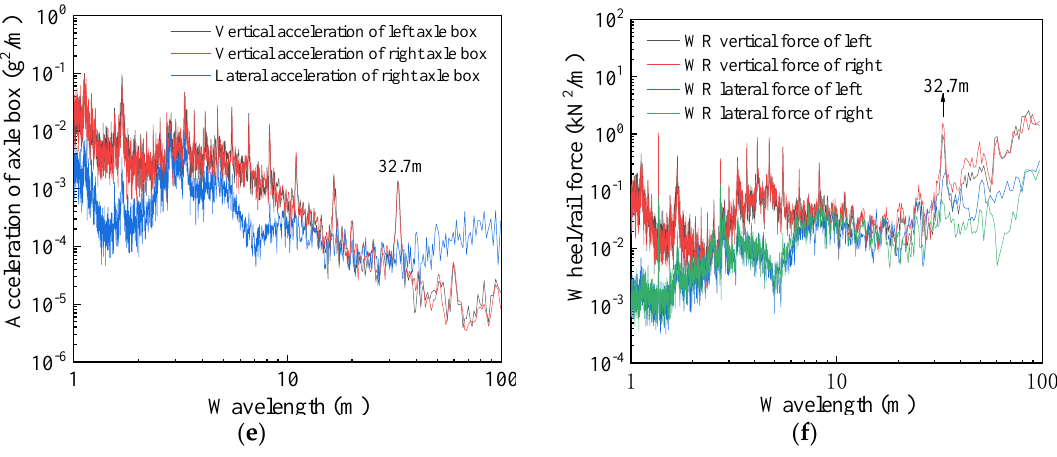
Figure 9. PSDs of track longitudinal level and vehicle response. ( a ) Track longitudinal level. ( b ) Track alignment. ( c ) Acceleration of car body. ( d ) Acceleration of bogie. ( e ) Acceleration of axle box. ( f ) Wheel/rail force.